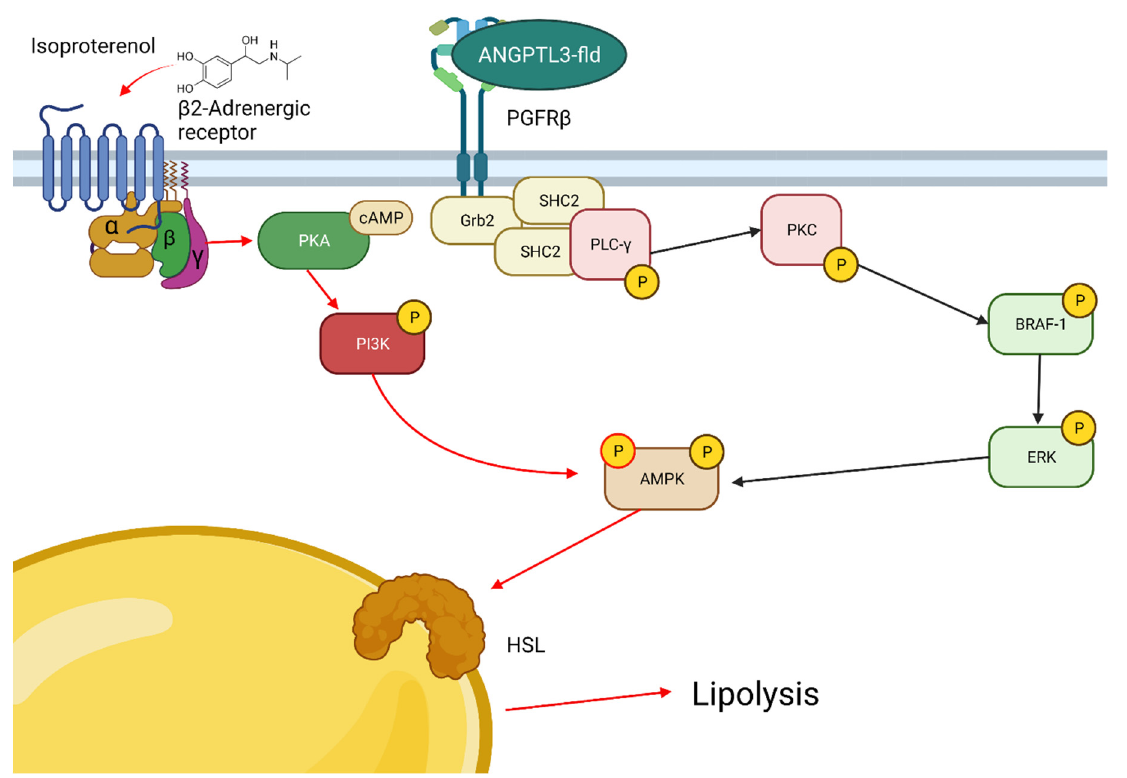
Figure 5. Molecular model describing the potential action ANGPTL3 fibrinogen-like domain function. Possible intracellular pathways activated by ANGPTL3fld and interaction with the β -adrenergic signaling. ANGPTL3-mediated molecular pathways are shown in black. β -adrenergic downstream pathways are shown in red.